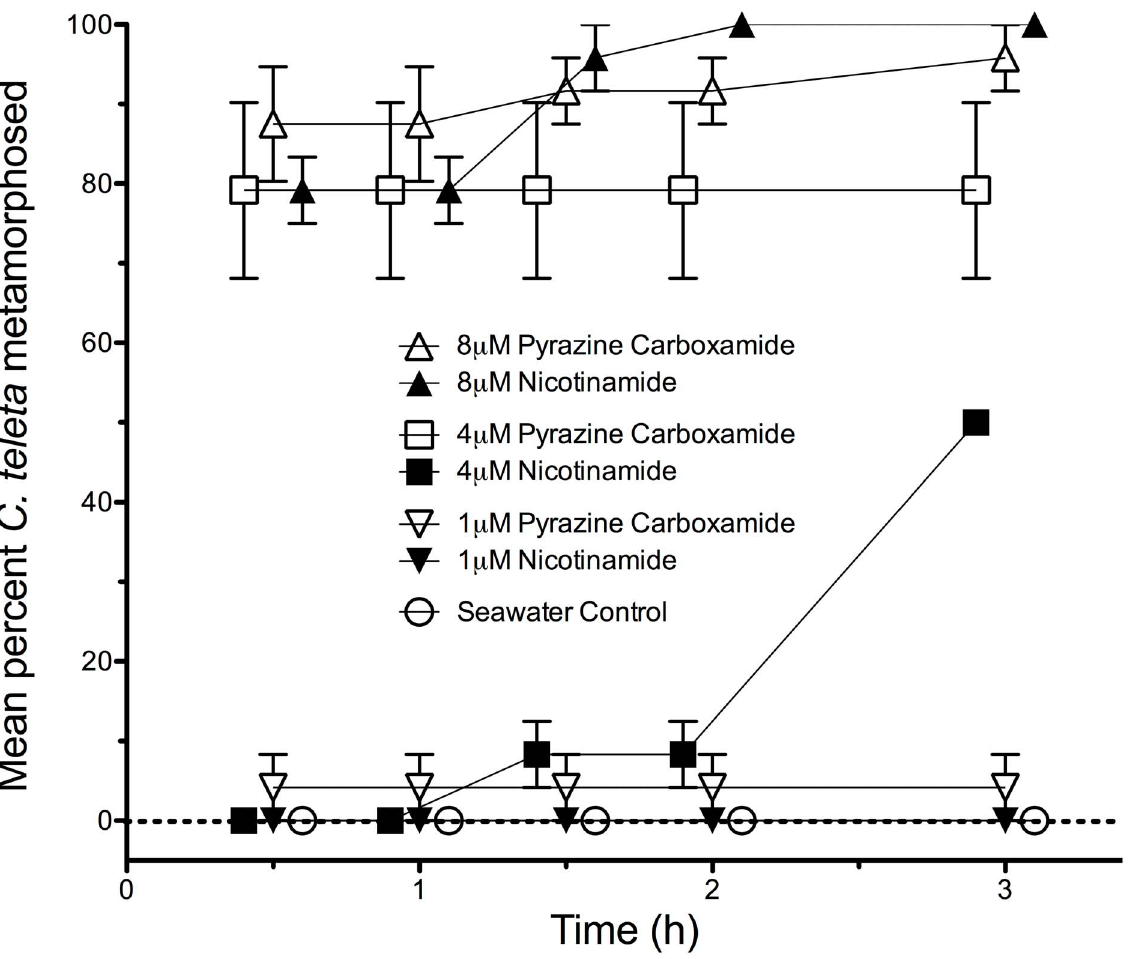
Figure 3. The effects of pyrazinecarboxamide and nicotinamide on metamorphosis of C.teleta when tested equal concentrations. Each treatment consisted of 3 replicates with 8 larvae per replicate. Artificial seawater (Instant Ocean) acted as a negative control. Error bars represent + / 2 1 s.e.m.